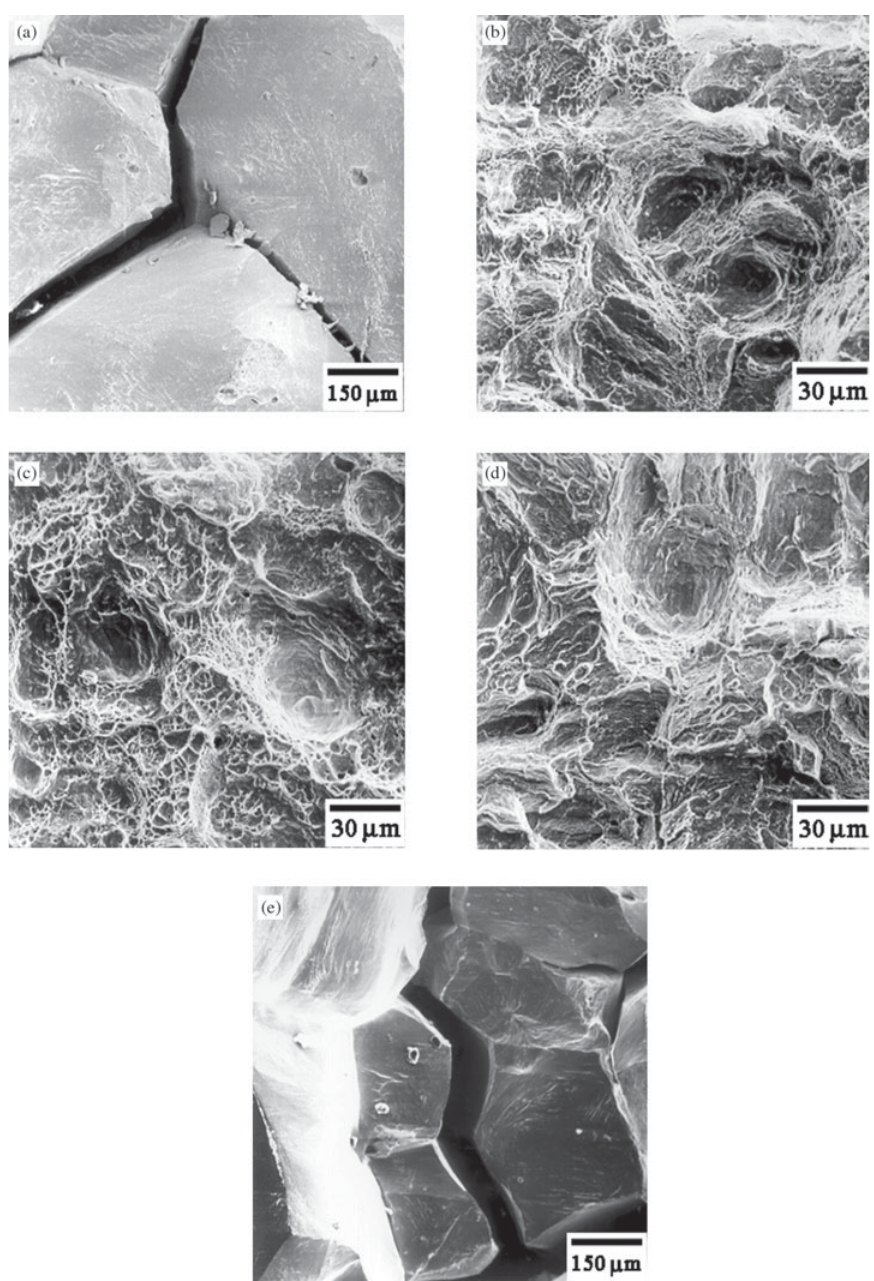
Figure 3. Fracture surface of specimens tested for J-R curves. A508-3A steel submitted to Q&T thermal cycles: a) I , b) J , c) K , d) L and e) M . Crack growth direction is from the bottom to the top of the